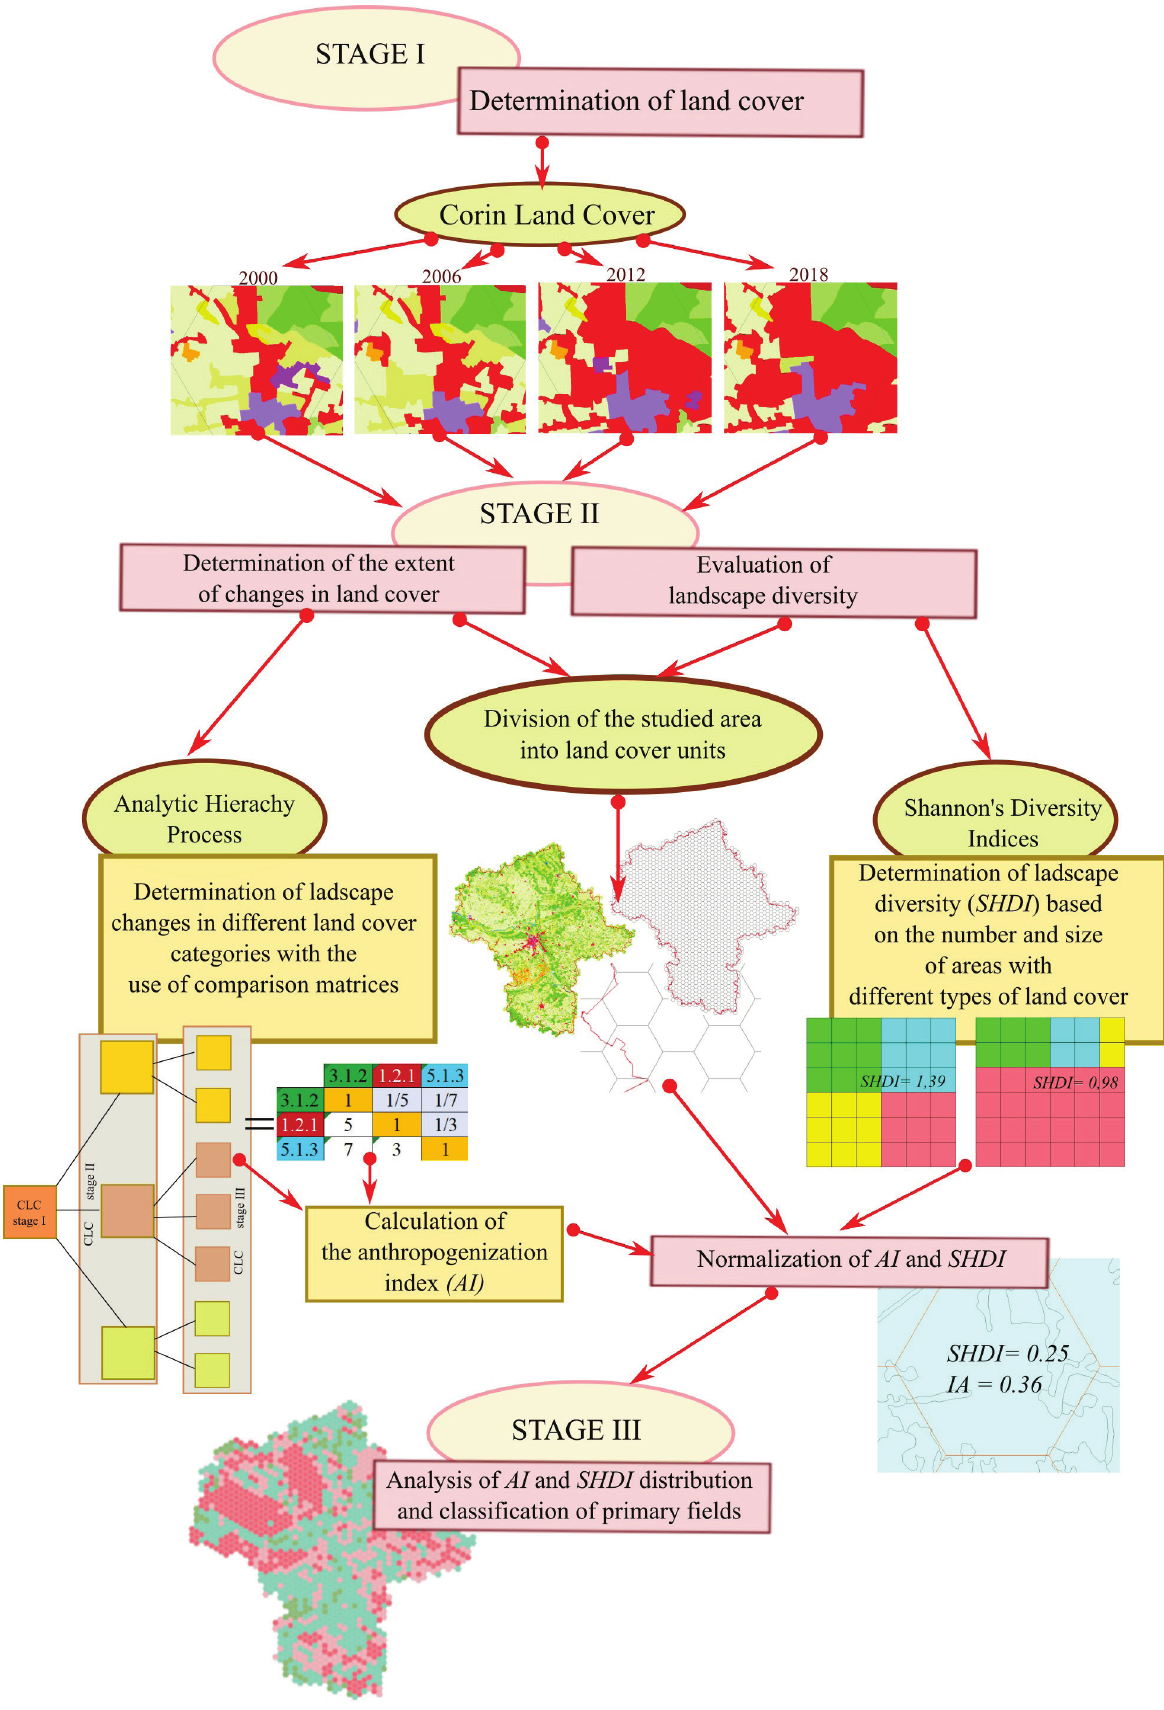
Figure 1. Diagram of the research